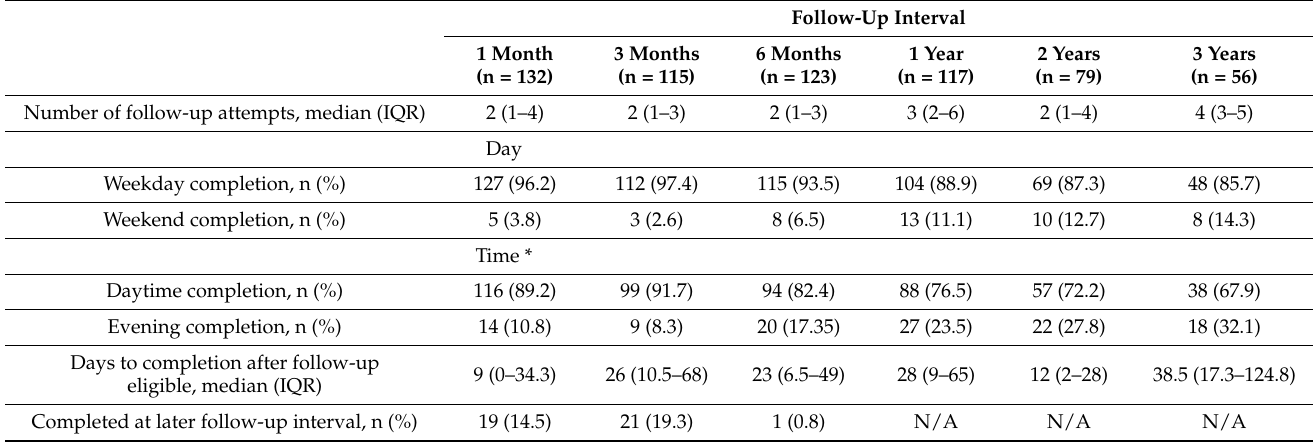
Table 2. Characteristics of successful follow-up